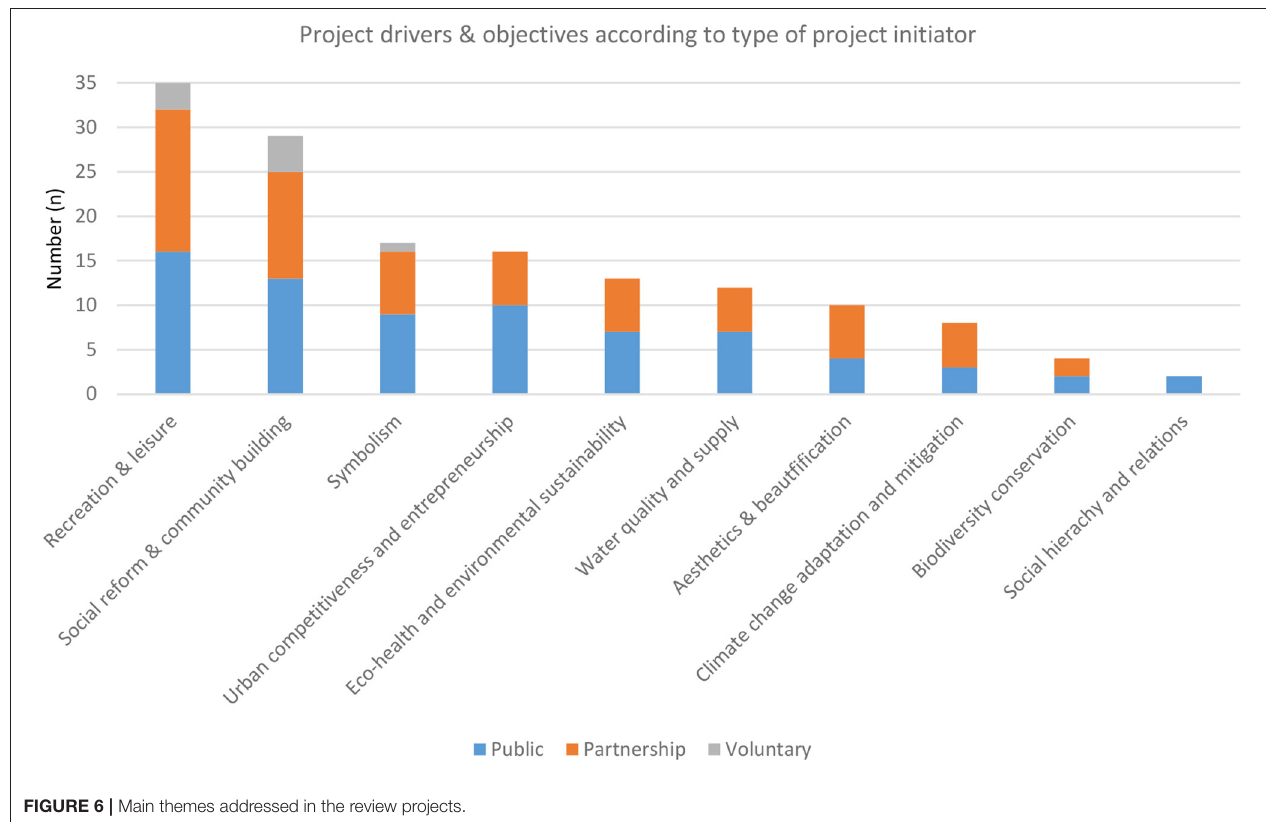
FIGURE 6 | Main themes addressed in the review projects.